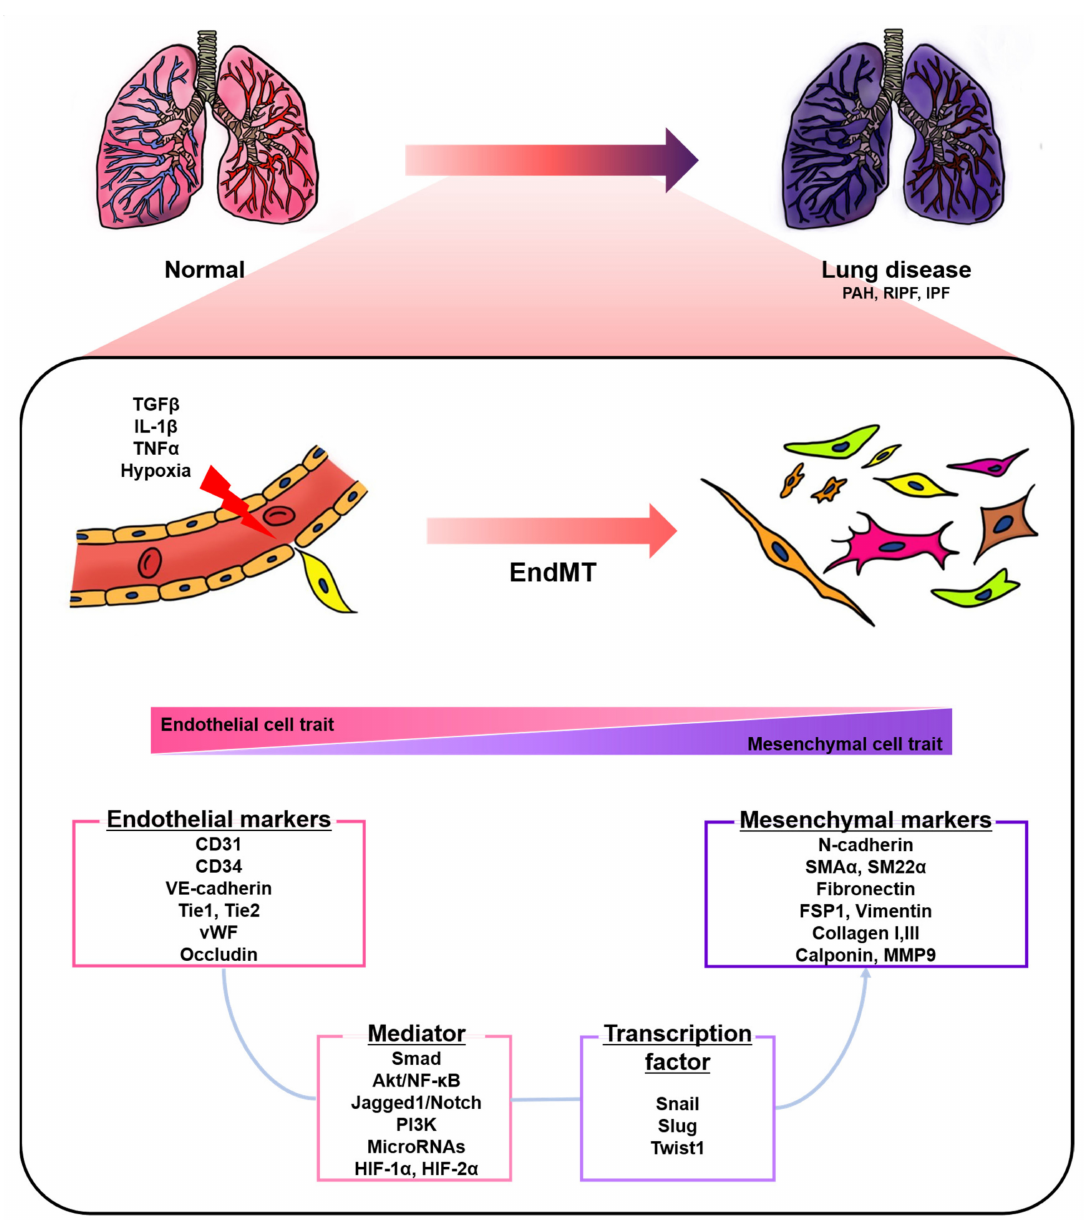
Figure 1. A schematic representation of endothelial-to-mesenchymal transition (EndMT) involved in lung diseases. Endothelial cells stimulated by transforming growth factor- β (TGF β ), interleukin 1 beta (IL-1 β ), tumor necrosis factor alpha (TNF α ), and hypoxia undergo EndMT. EndMT is characterized by phenotypic change from a cobblestone into an elongated shape, loss of endothelial markers, and the acquisition of mesenchymal markers. EndMT contributes to the pathogenesis of lung diseases, including pulmonary arterial hypertension (PAH), radiation-induced pulmonary fibrosis (RIPF), and idiopathic pulmonary fibrosis (IPF). Various mediators and transcription factors are identified in this